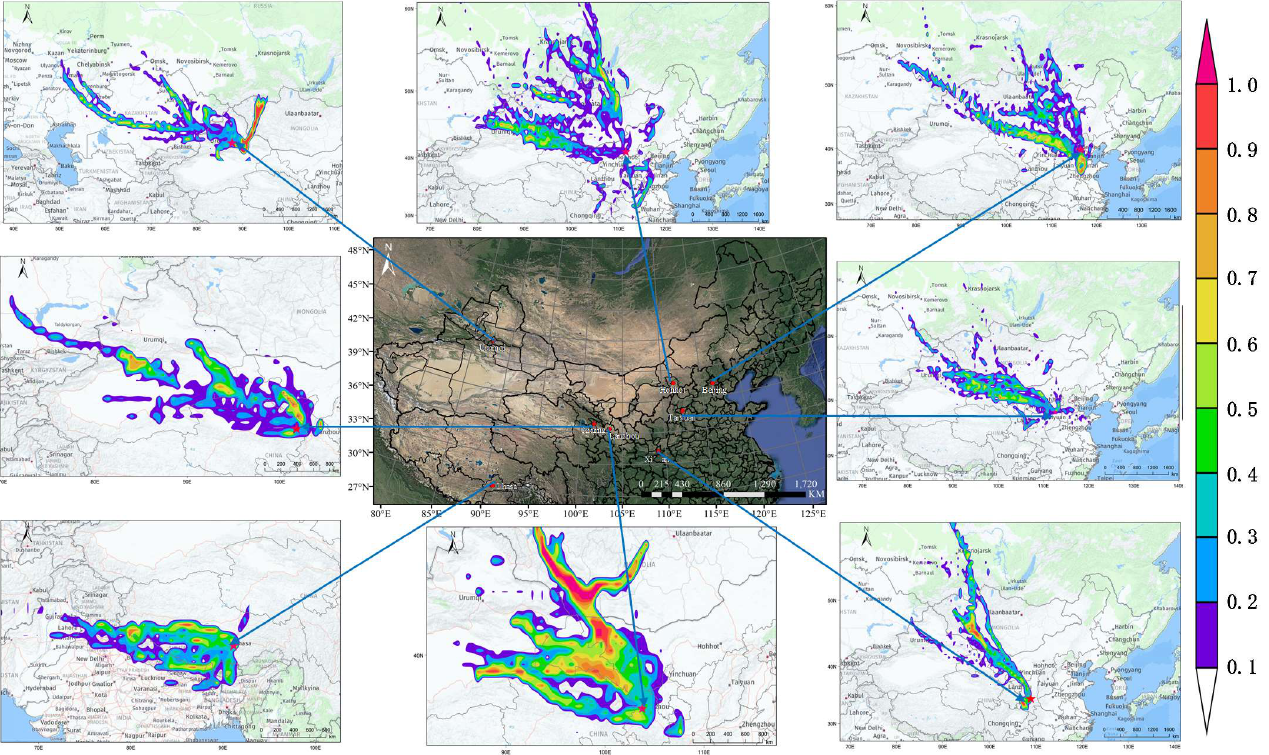
Figure 7. Potential source contribution of PM 10 in dust storm events for different cities (2015 to 2020).